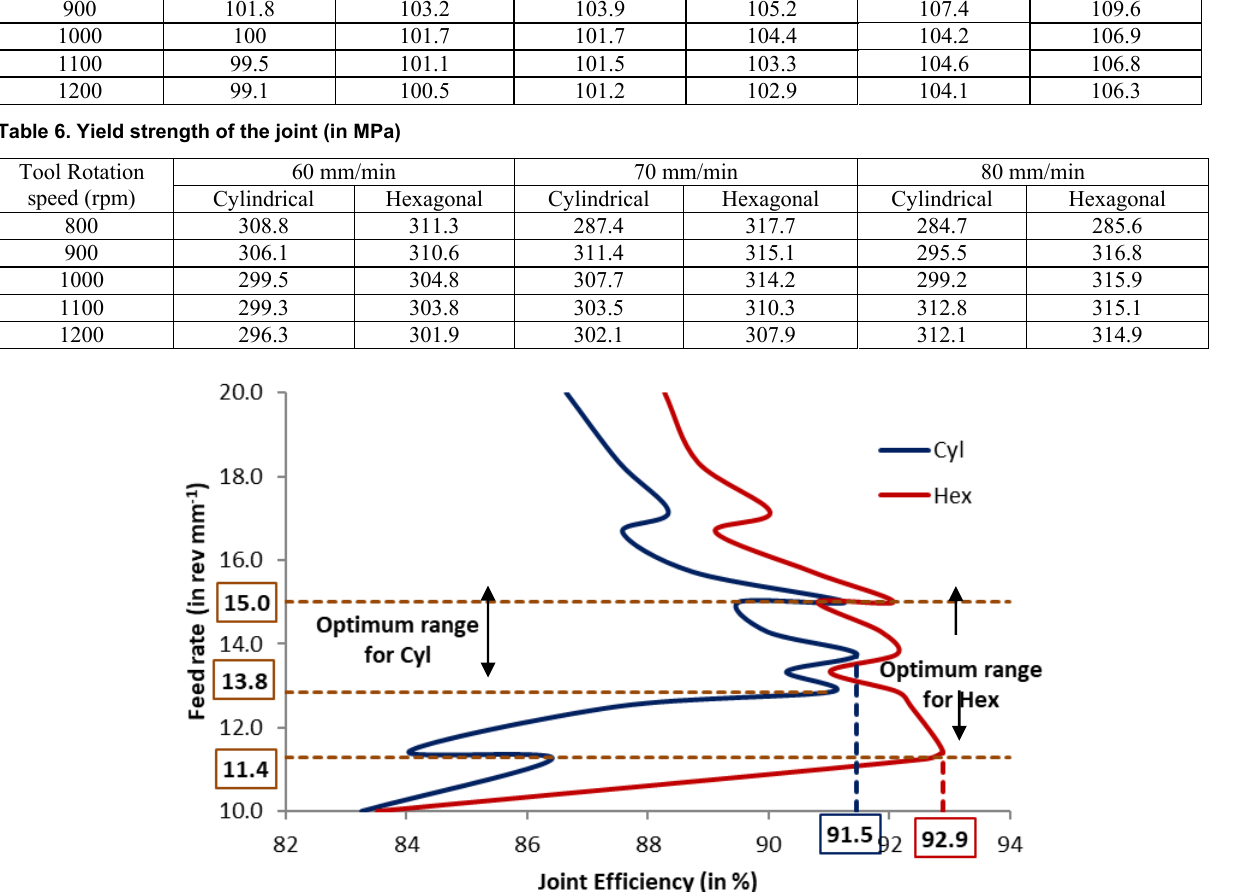
Table 5. Lowest hardness value(HV)in heat affected zone (HAZ) Tool Rotation